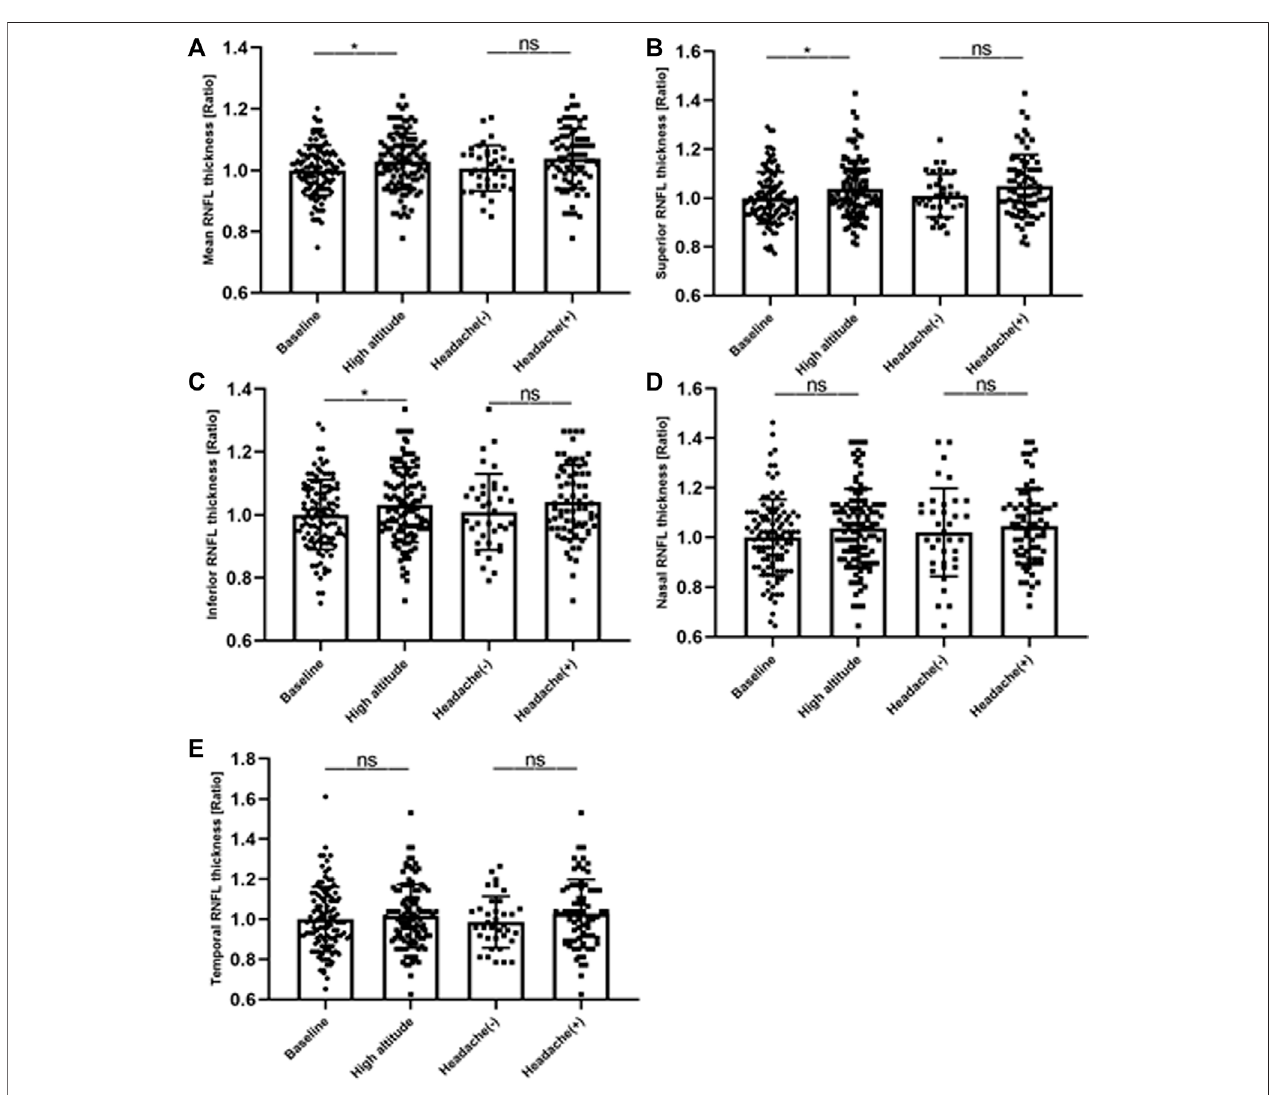
FIGURE 3 | Changes in thickness of RNFL in peripapillary sectors. Intraindividual changes (expressed as ratios) at high altitude. (A) mean RFNL thickness, (B) superior RNFL thickness (C) inferior RNFL thickness, (D) nasal RNFL thickness and (E) temporal RNFL thickness. RNFL, retinal nerve fi ber layer; HAH (+), high altitude headache (HAH); (HAH) ( − ), none-HAH; *p value indicates p < 0.05; **p <